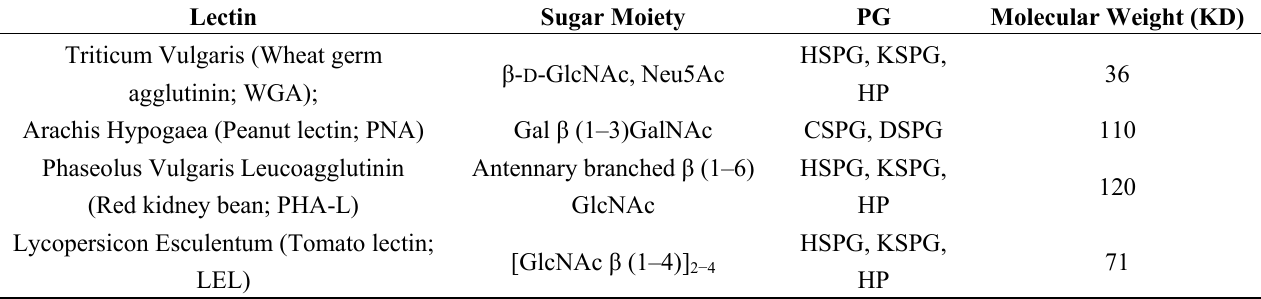
Table 1. Lectins and their corresponding binding sugar moiety/proteoglycan [22,26–28]. Lectin Sugar Moiety PG Molecular Weight (KD) Triticum Vulgaris (Wheat germ HSPG, KSPG, β - D -GlcNAc, Neu5Ac 36 agglutinin; WGA); HP Arachis Hypogaea (Peanut lectin; PNA) Gal β (1–3)GalNAc CSPG, DSPG 110 Phaseolus Vulgaris Leucoagglutinin Antennary branched β (1–6) HSPG, KSPG, 120 (Red kidney bean; PHA-L) GlcNAc HP Lycopersicon Esculentum (Tomato lectin; HSPG, KSPG, [GlcNAc β (1–4)] 2 − 4 LEL) HP